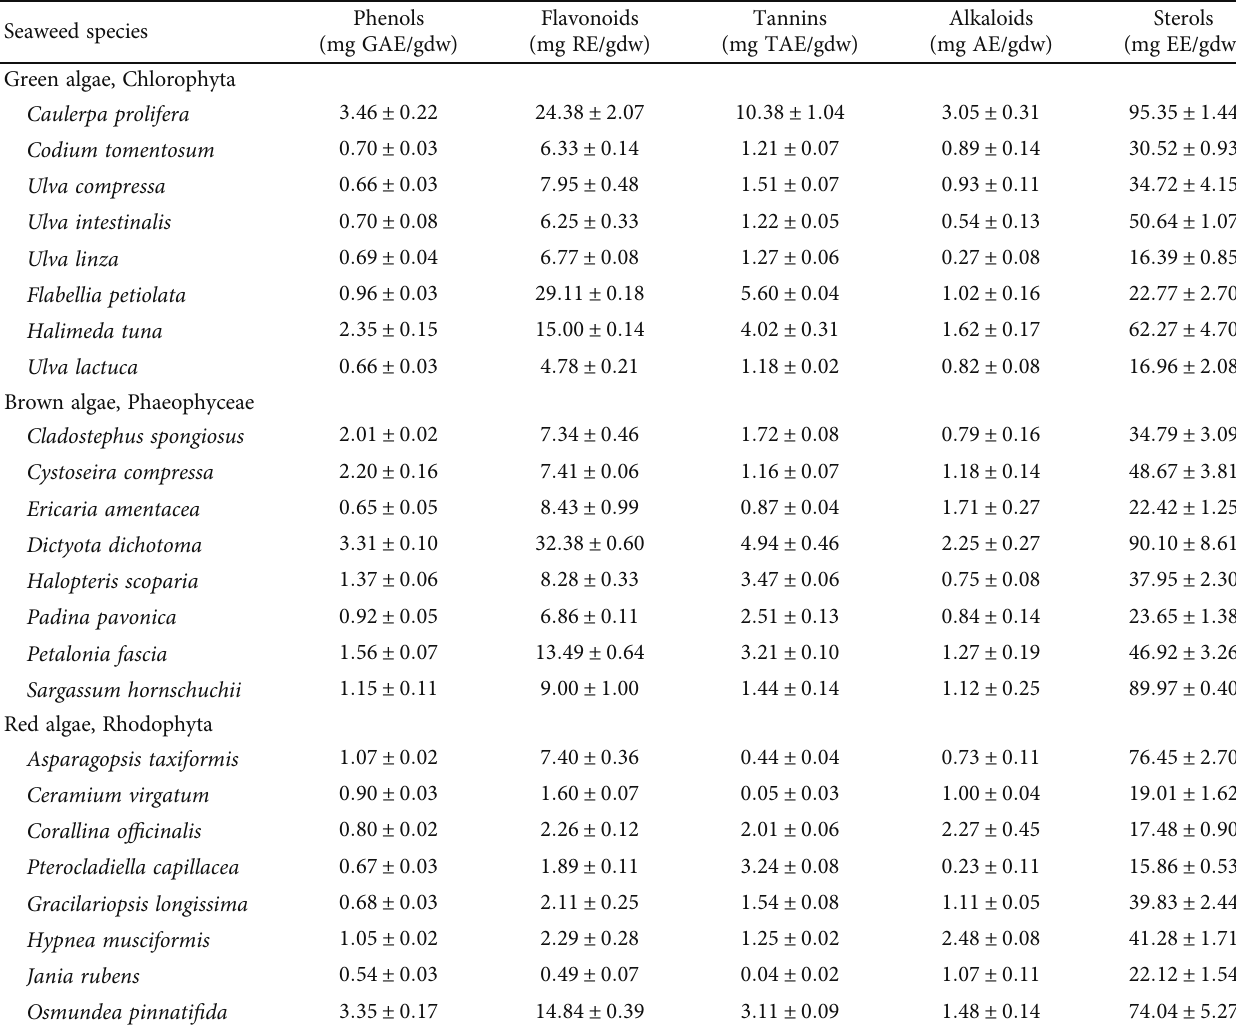
Table 2: Bioactive